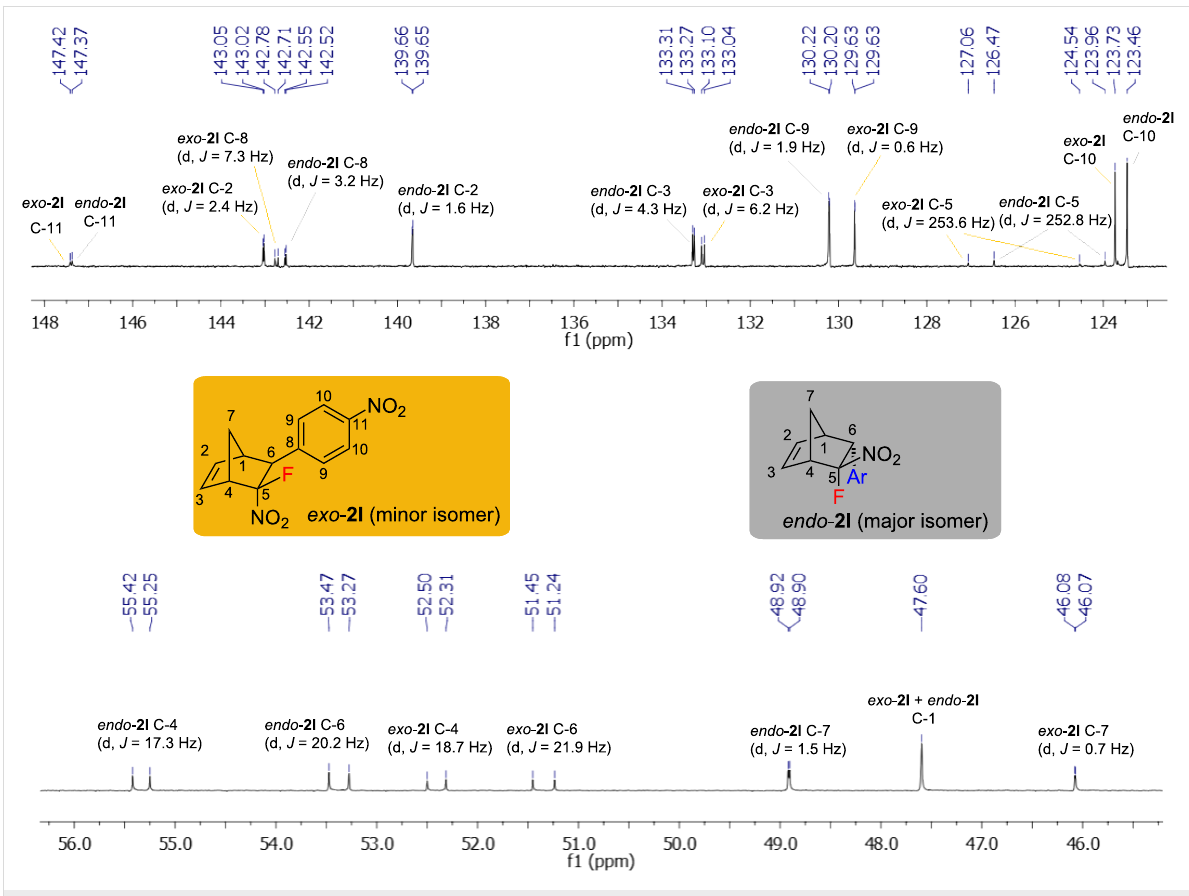
Figure 2: 13 C NMR spectrum of the mixture of exo - and endo -isomers of norbornene 2l .